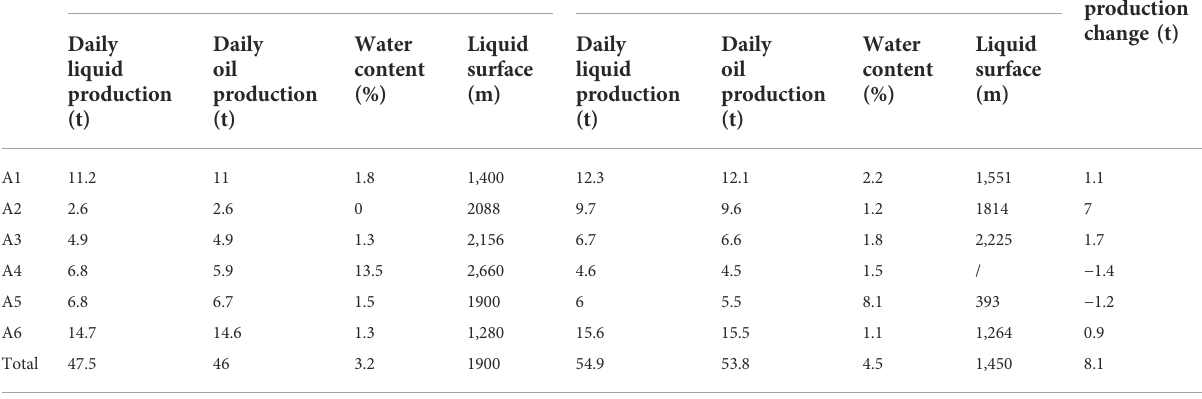
TABLE 1 Statistical results of productivity effectiveness of A1 well group.